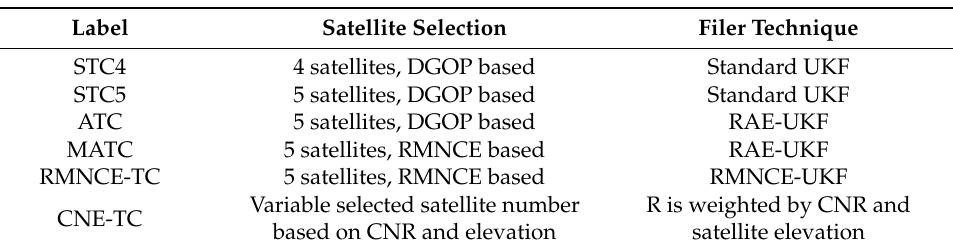
Table 7. Different schemes during the test.